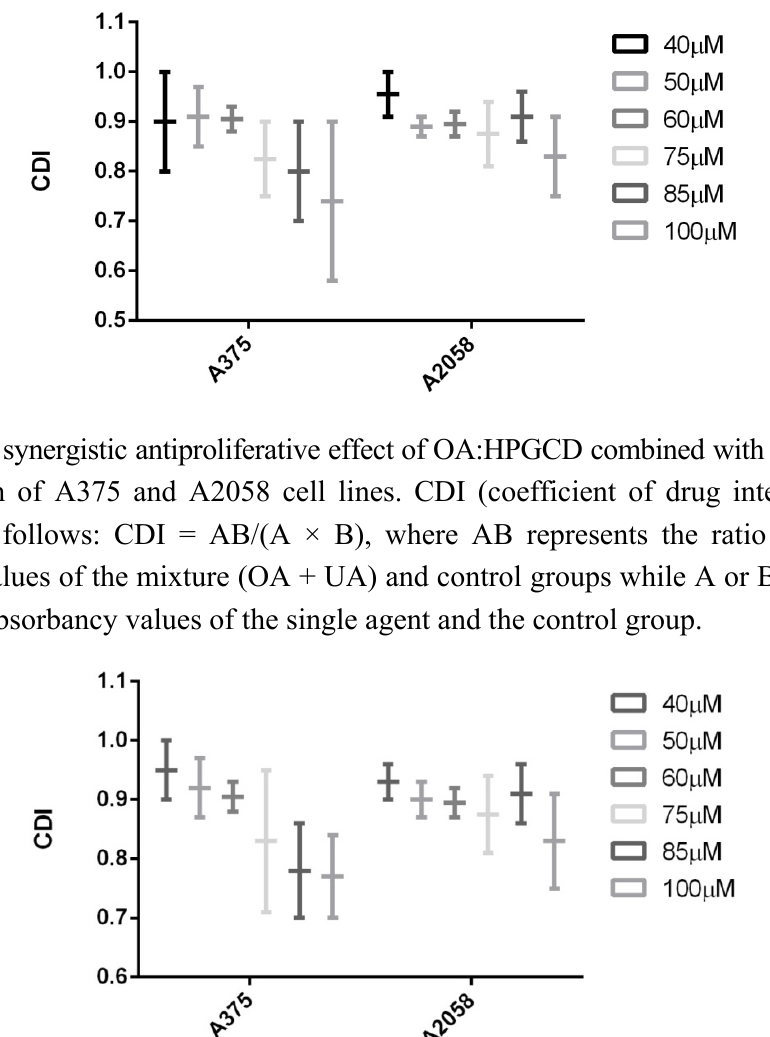
Figure 5. The synergistic antiproliferative effect of OA combined with UA on the growth of A375 and A2058 cell lines. CDI (coefficient of drug interaction) was calculated as follows: CDI = AB/(A × B), where AB represents the ratio between the absorbancy values of the mixture (OA + UA) and control groups while A or B are the ratio between the absorbancy values of the single agent and the control group.